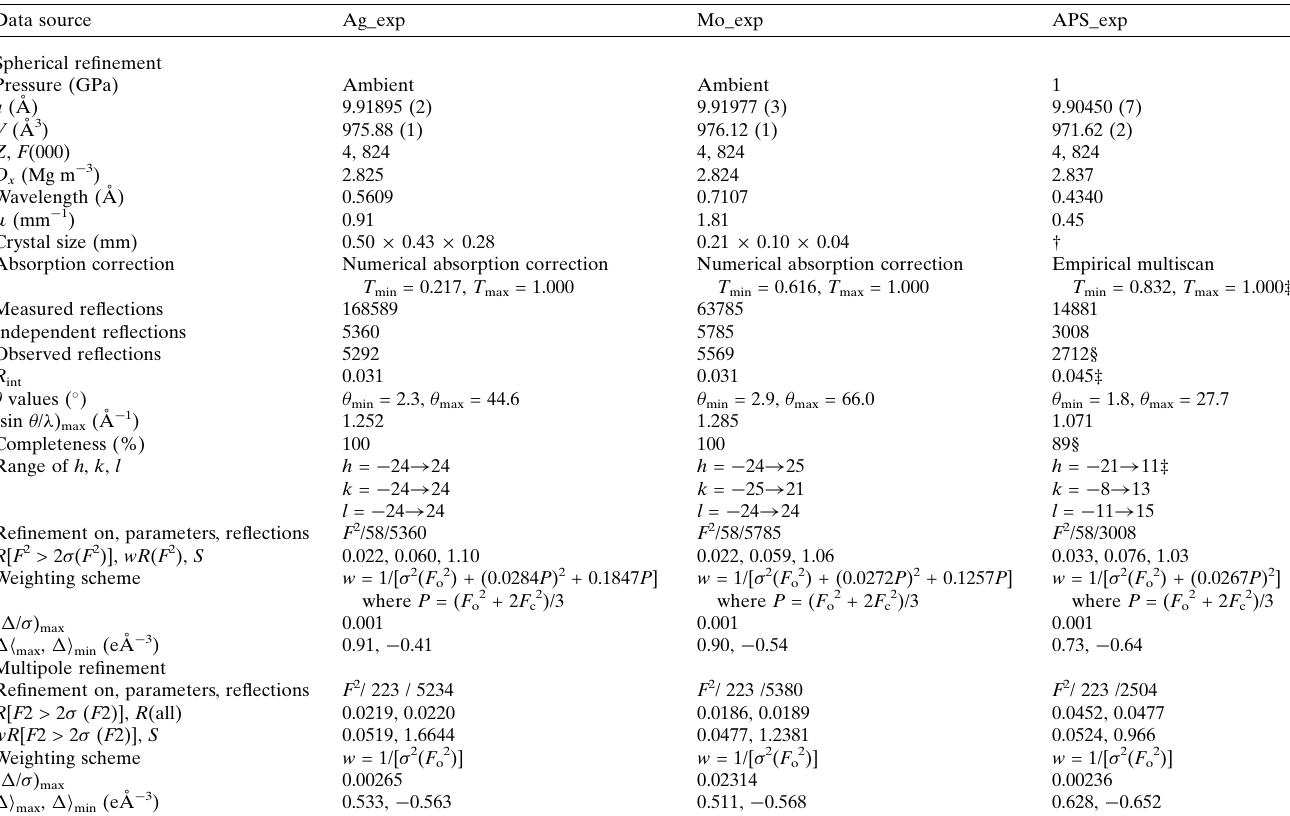
Table 1 Selected crystal data for spherical and multipole refinements of langbeinite at ambient pressure and at 1 GPa. Detailed tables of structural and experimental parameters, data completeness, and comparison of statistical characteristics of the datasets are provided in the supporting